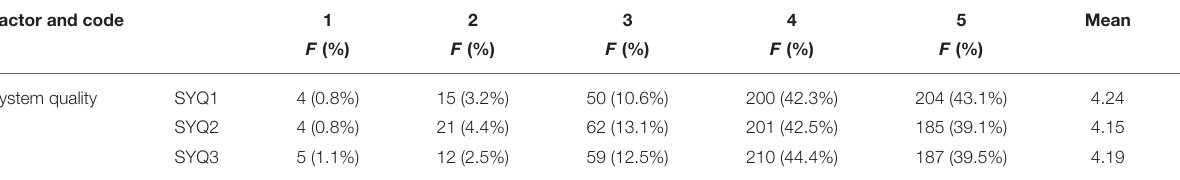
TABLE 6 | Measuring system quality (SYQ).